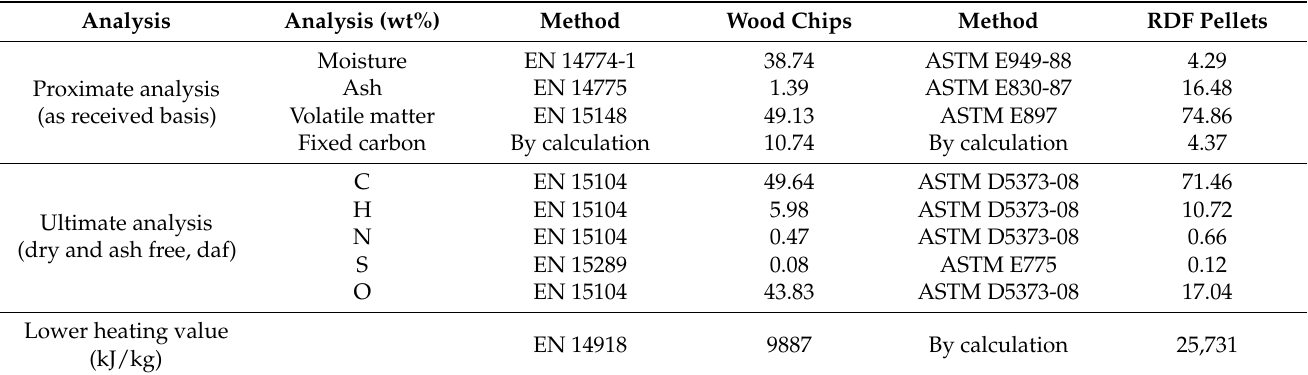
Table 2. Proximate and ultimate analysis results of wood chips and RDF pellets.